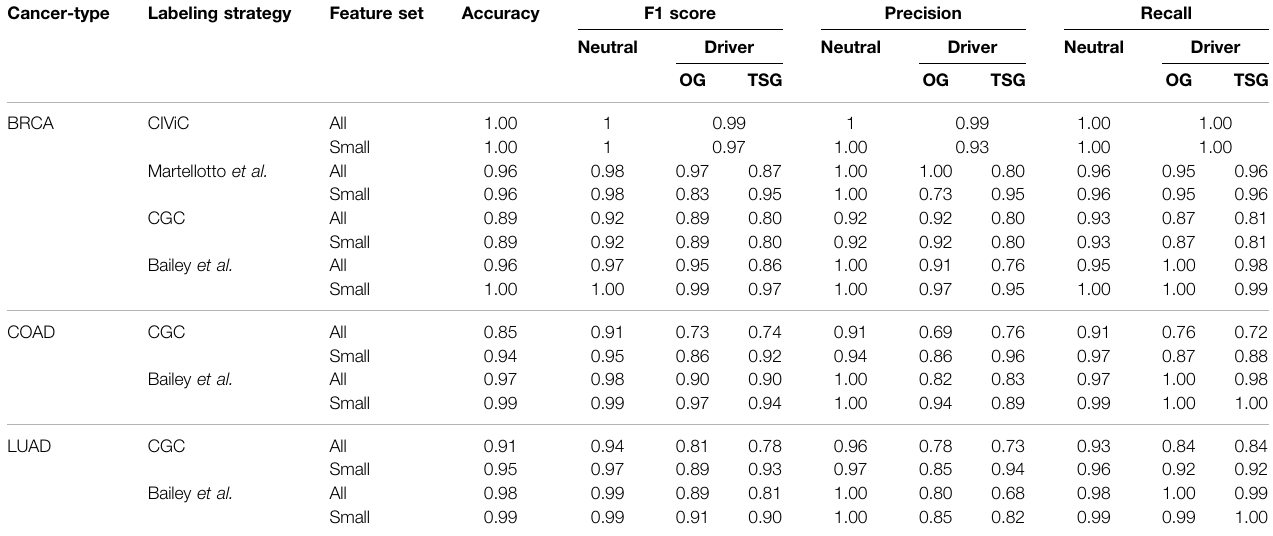
TABLE 4 | Classi fi cation metrics for best multi-omic models. Cancer-type Labeling strategy Feature